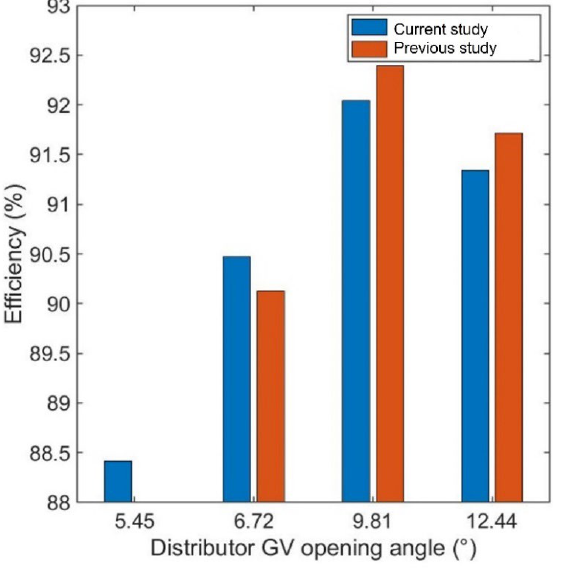
Figure 5. Efficiency comparison between the current and the old test rig at different operating conditions.